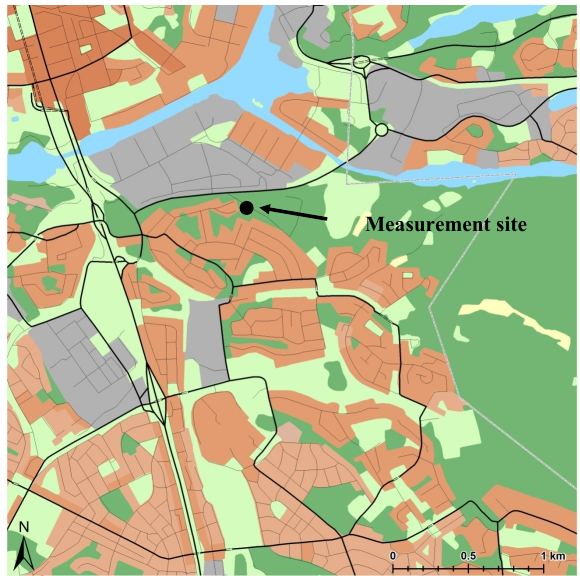
Fig 1 : Shows the location of the tower in Stockholm and its surroundings. Blue = open water surfaces, green = forest/park areas, brown/orange/grey = built-up areas (mainly residential areas), public buildings (schools, sport arenas etc), black= roads.